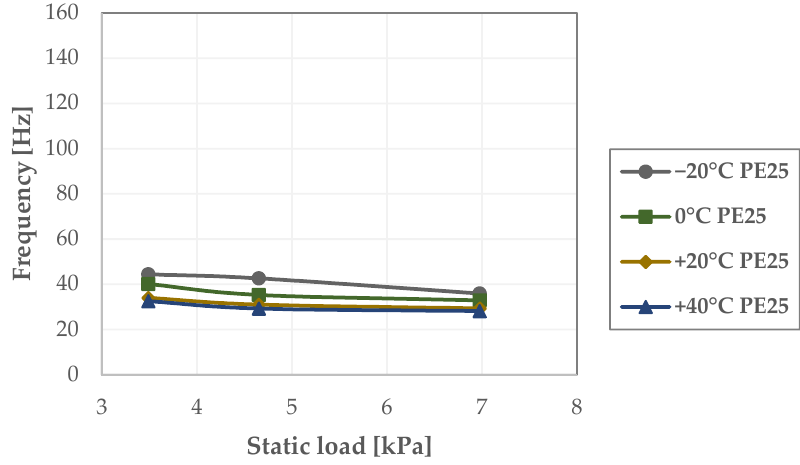
Figure 12. Resonant frequencies of PE25 as a function of temperature.